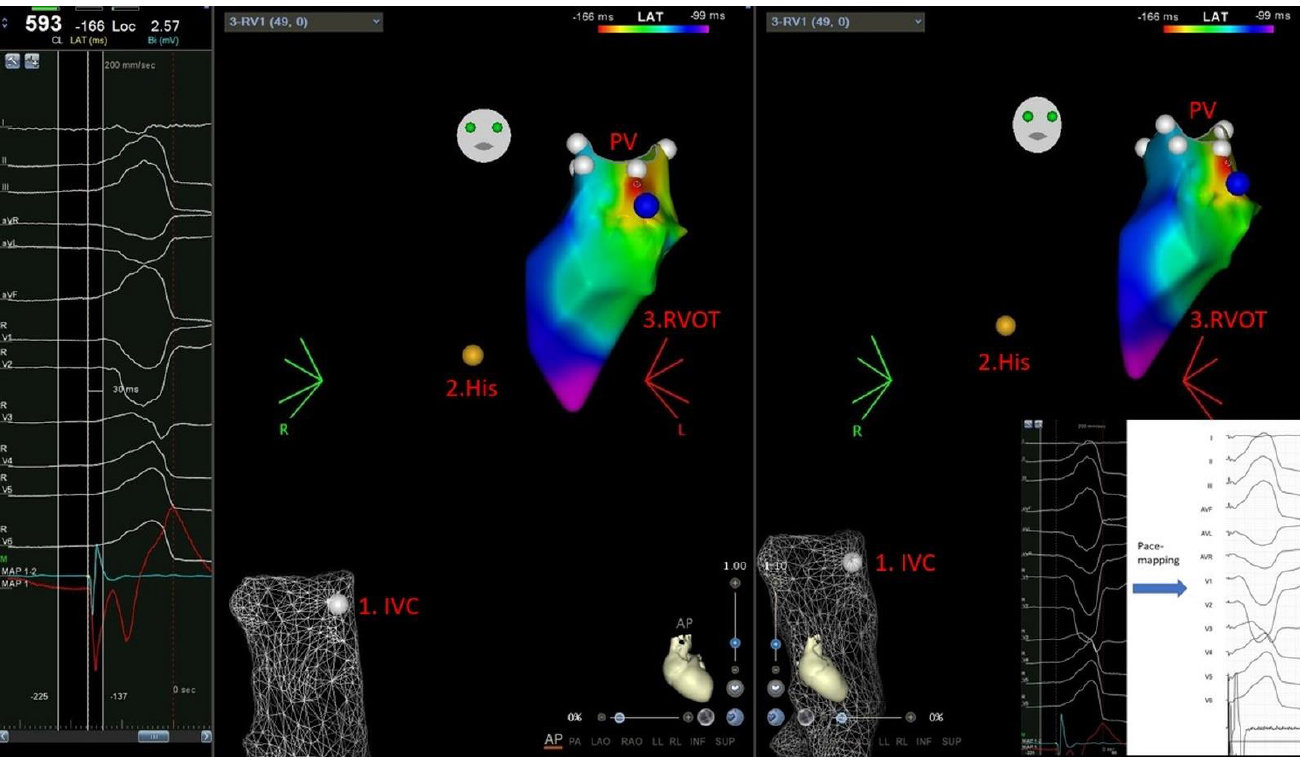
Figure 1. A. Activation map of premature ventricular contraction (PVC) from right ventricular outflow tract-RVOT (CARTO Biosense Webster Inc., Irvine, CA, USA) performed without fluoroscopy. First stage of the procedure is FAM of IVC and CF sensor calibration (if used). Second stage is His potential (yellow dot) localization and performance of respiratory gating. The third stage is performance of point-by-point activation mapping supported with pace-mapping. In showed case, earliest endocardial potential advancing PVC-QRS-30 ms (with automatic reference annotation) - spot of RF application, blue dot-a spot of optimal pace-mapping with compatibility with PVC > 95%. White dots - PV marked. AP and RAO projections. Abbreviations: CF, contact force; FAM, fast anatomical mapping; IVC, inferior vena cava; PVC, premature ventricular contraction; PV, pulmonary valve.